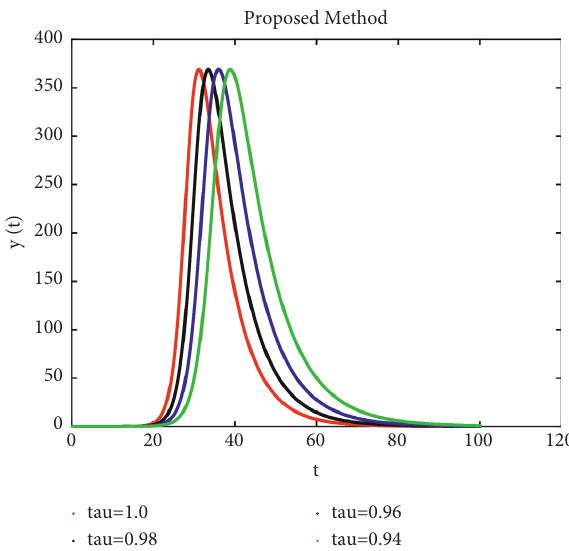
Figure 4: Dynamical behavior infected cells at α � 1 and fractal order under power law